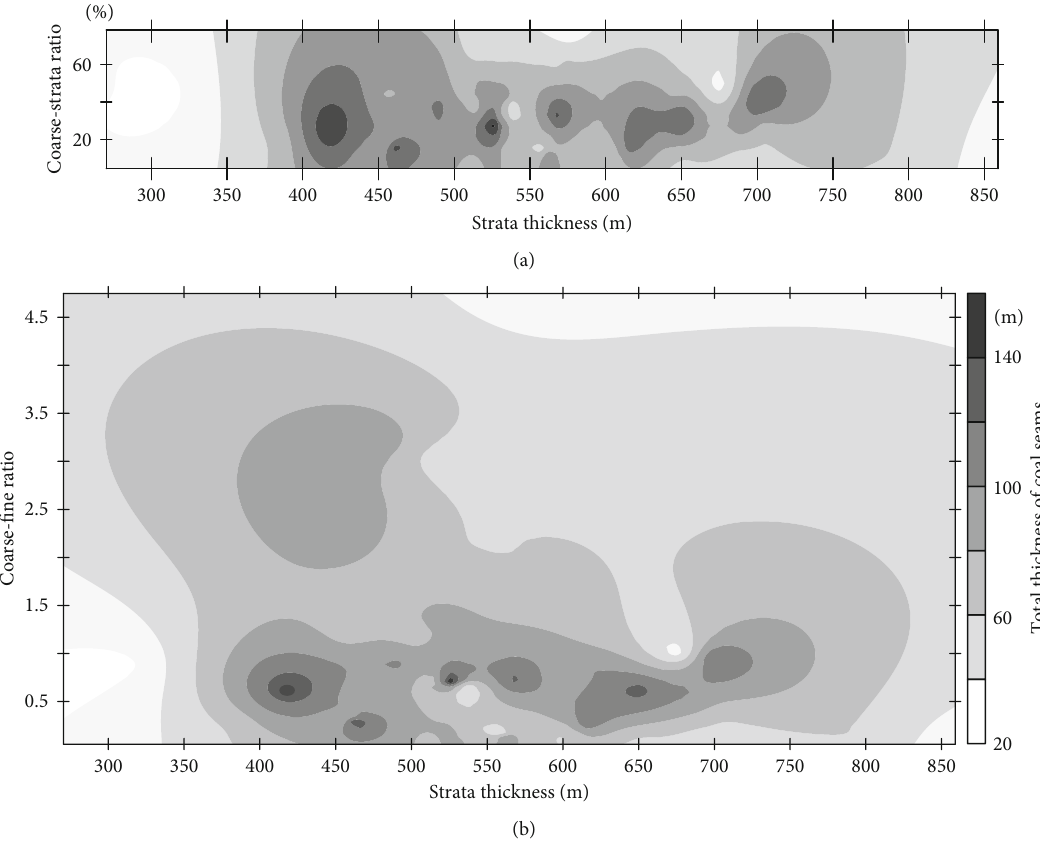
Figure 5: Analysis of control factors on coal accumulation: (a) relationship between coal thickness, stratum thickness, and coarse sediment (conglomerate and sandstone) - strata ratio; (b) relationship between coal thickness, stratum thickness, and coarse (conglomerate and sandstone) - fi ne (siltstone and mudstone)